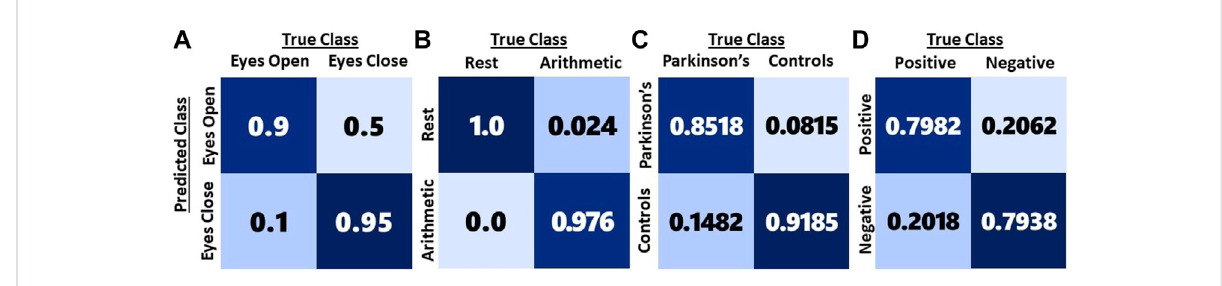
FIGURE 6 Confusion matrices of high performing multi-dimensional EEG representations for the four datasets. (A) EEG baseline dataset using the EEG video. (B) Mental Arithmetic dataset using the EEG video. (C) Parkinson ’ s disease dataset using 1D features. (D) Emotion dataset using the composite feature set consisting of 2D feature maps and 1D